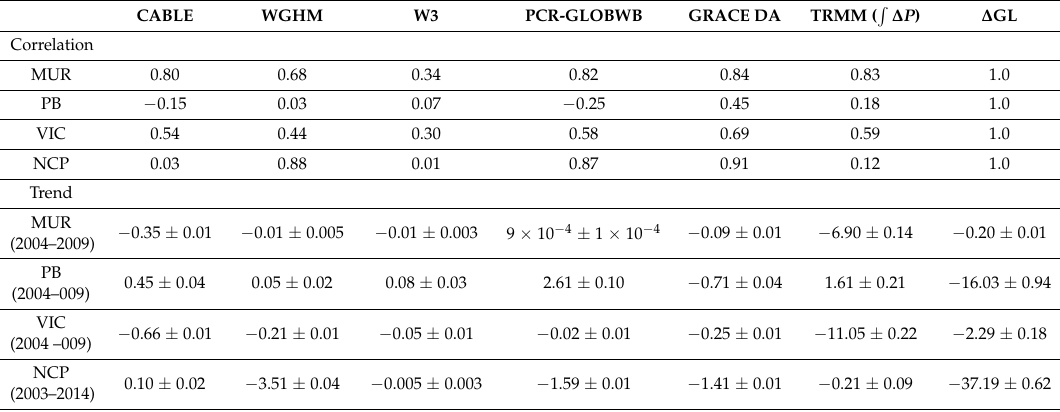
Figure 12. The Δ GWS estimates (left axis) from four models and GRACE DA in Murray-Darling basin. The in situ Δ GL data as well as the yearly rainfall (cm/month/year) and (cid:1516) ∆P (see text for the description) are also shown (right axis). Table 3. The correlation coefficient (respect to in situ ∆ GL data) and long-term trend (cm/year) of the ∆ GWS estimates from four different models, GRACE DA, TRMM ( (cid:82) ∆ P ), and in situ ∆ GL in the basins with excessive groundwater consumption. The depletion period used to calculate the long-term trend is also shown.